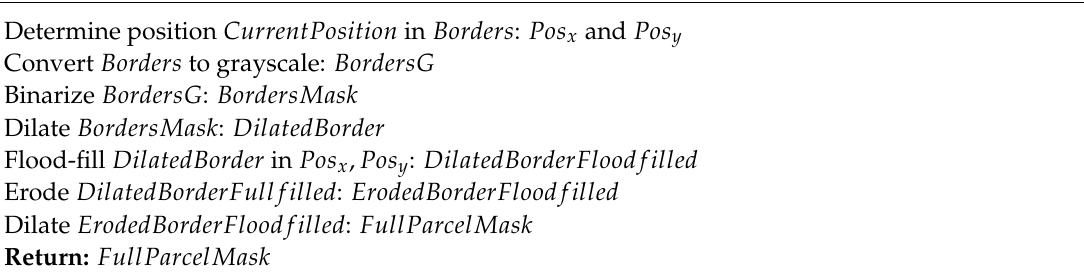
Algorithm 3 GenerateParcelMask{ CurrentPosition , Borders